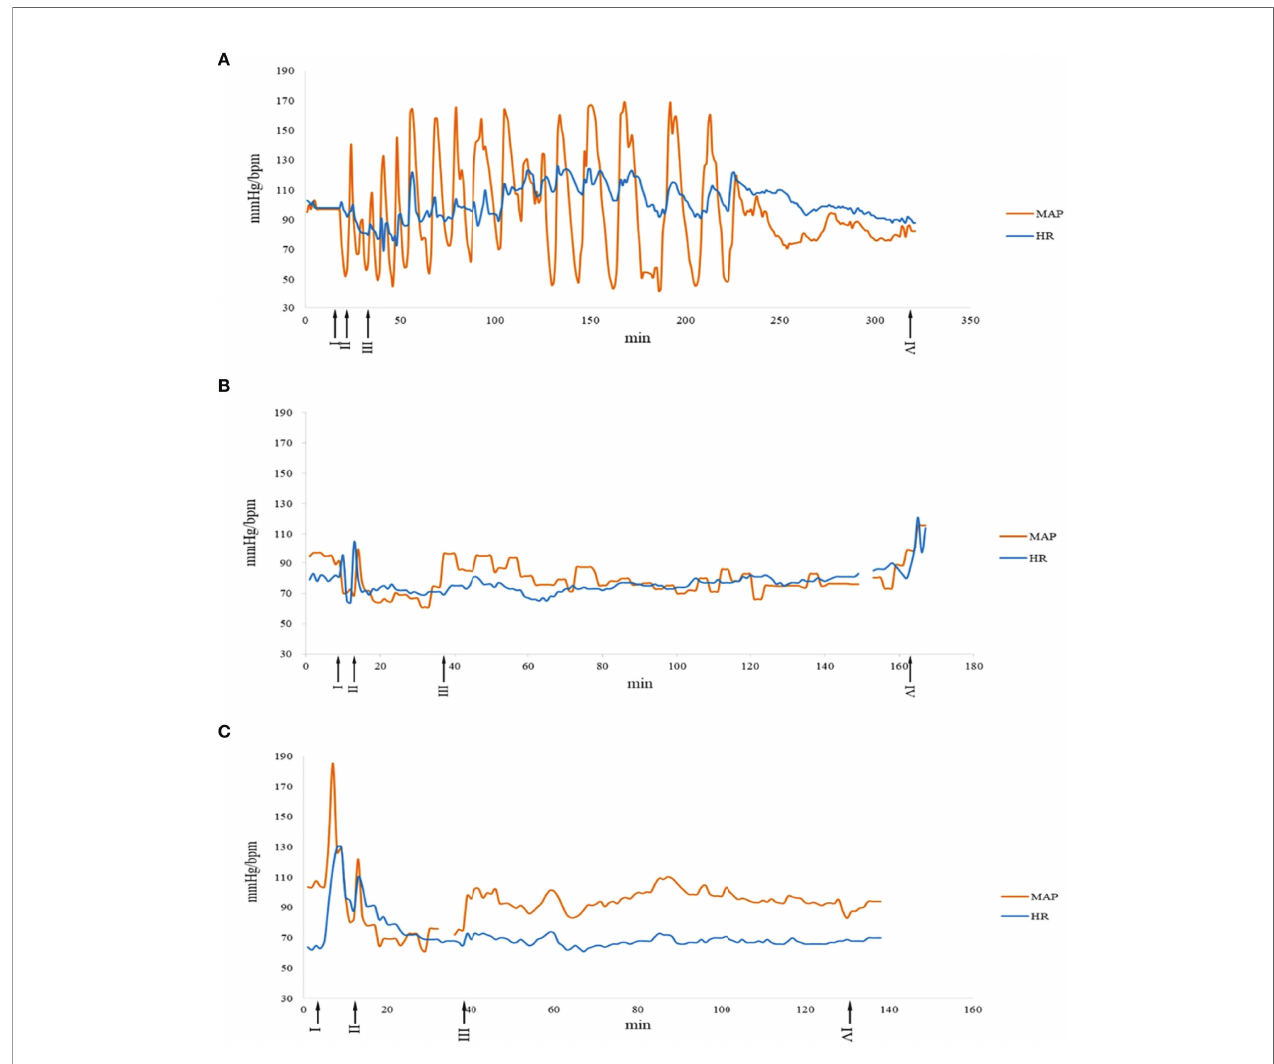
FIGURE 1 | Intraoperative hemodynamicchanges ofthreedifferenttypes ofsurgeriesinMEN2Apatients.A:surgeryNo. 24.1,B:surgeryNo. 1.1, C: surgeryNo.22.1. I: Anesthesia induction. II:Endotrachealintubation. III: Operationstarted.IV: Operation fi nished. Thecurve inbreakmeansthedatalost. MAP, meanarterialpressure;HR,heartrate.